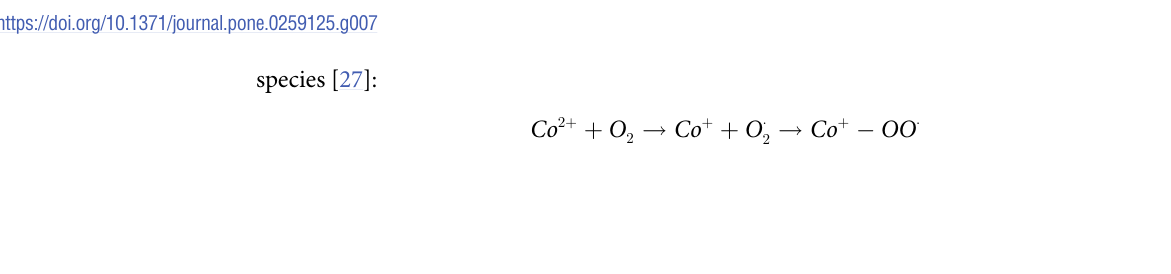
Fig 7. HUVEC viability, cell number and morphology with Cu 2+ and Co 2+ supplementation. (A) Viability and (B) morphology of HUVEC under different combinations of Cu 2+ and Co 2+ (actin filament staining (green); nucleus (blue). Scale bar = 50 μ m. Abbreviations: Cu5/Co12.5 = 5 μ M of Cu 2+ and 12.5 μ M of Co 2+ ; Cu10/Co25 = 10 μ M of Cu 2+ and 25 μ M of Co 2+ . Statistically significant differences were represented with � (p <